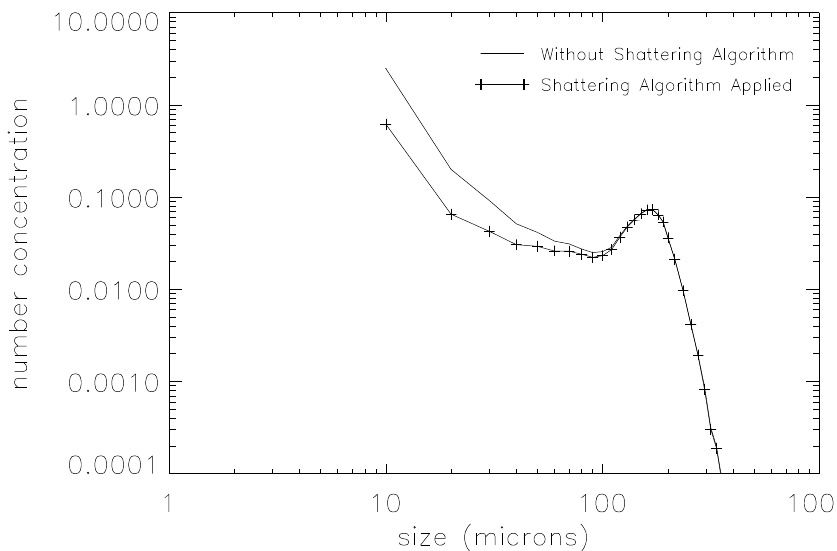
Fig. 5. Measured 2D-S ice particle size distributions both with and without application of a shattering algorithm (Lawson, 2011) used to correct for possible shattering effects for the 17 March large crystal